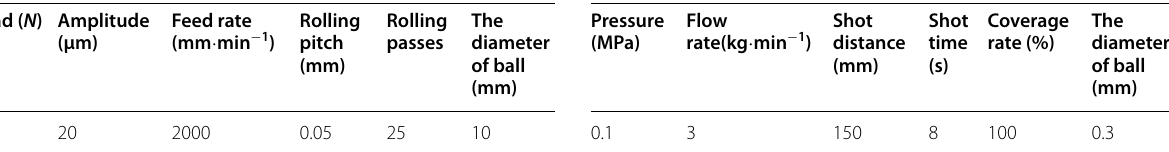
Table 3 The parameters of USRP Table 4 The parameters of